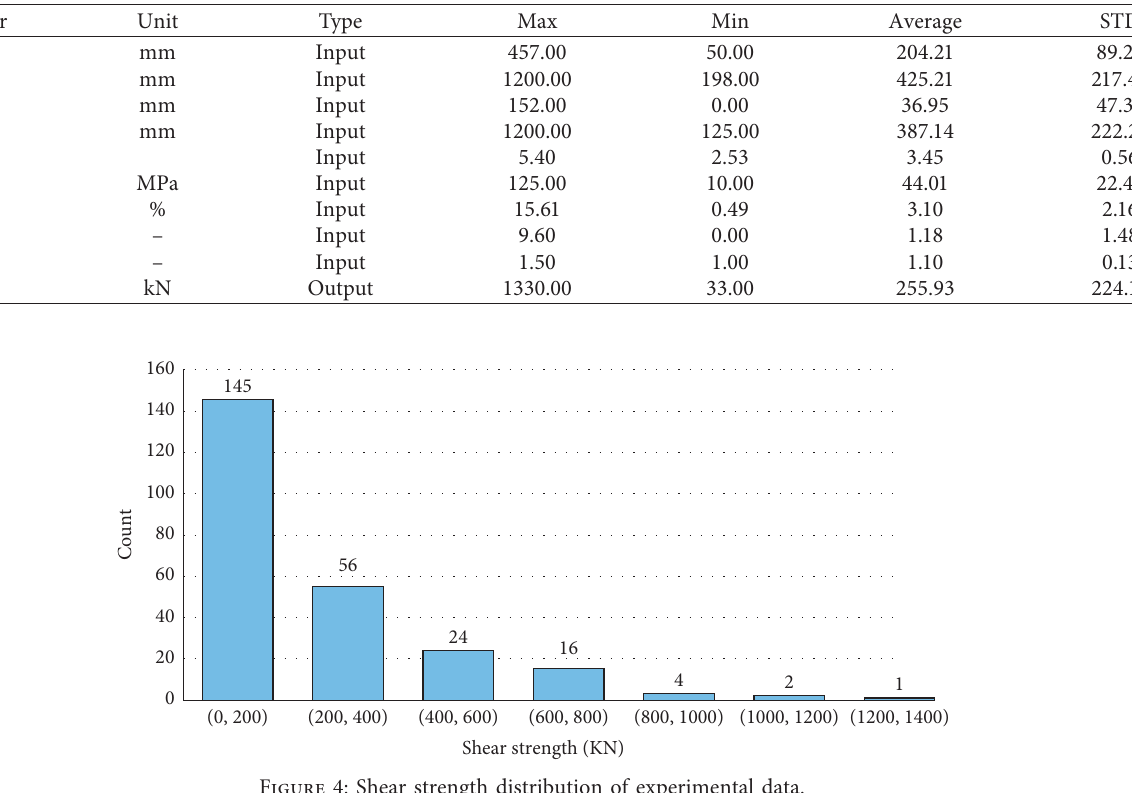
Figure 3: Flowchart of the tabu search training algorithm. Table 1: Descriptive statistics of collected experimental data.